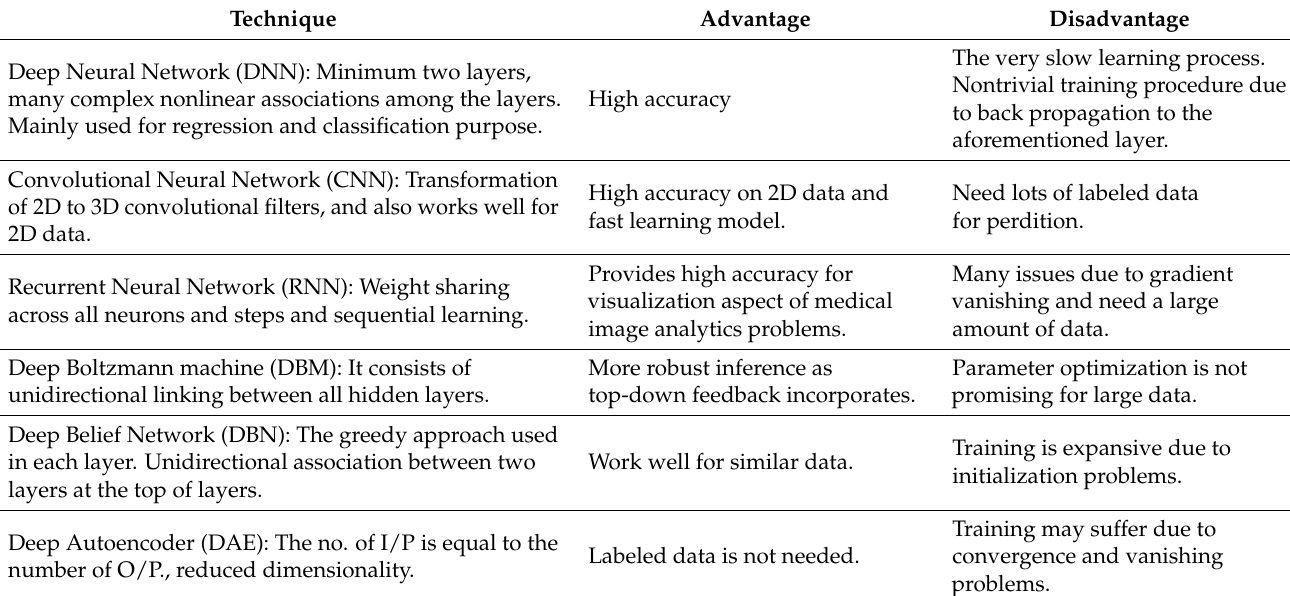
Table 2. Frequently used deep learning techniques and their uses.